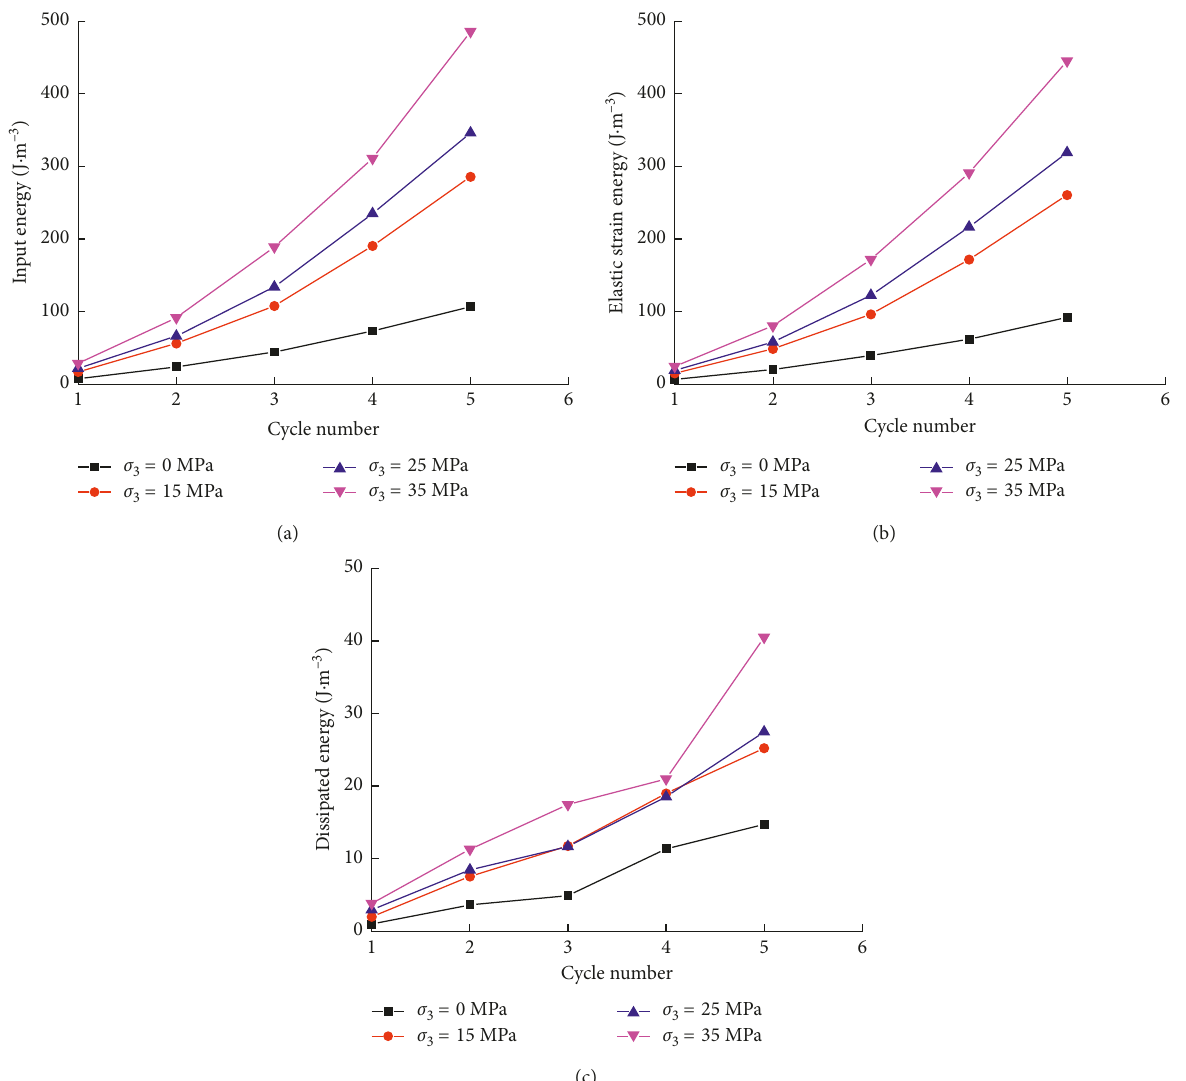
Figure 10: Variations of energy with cycle number under different confining pressures. (a) Input energy; (b) elastic strain energy; (c) dissipated